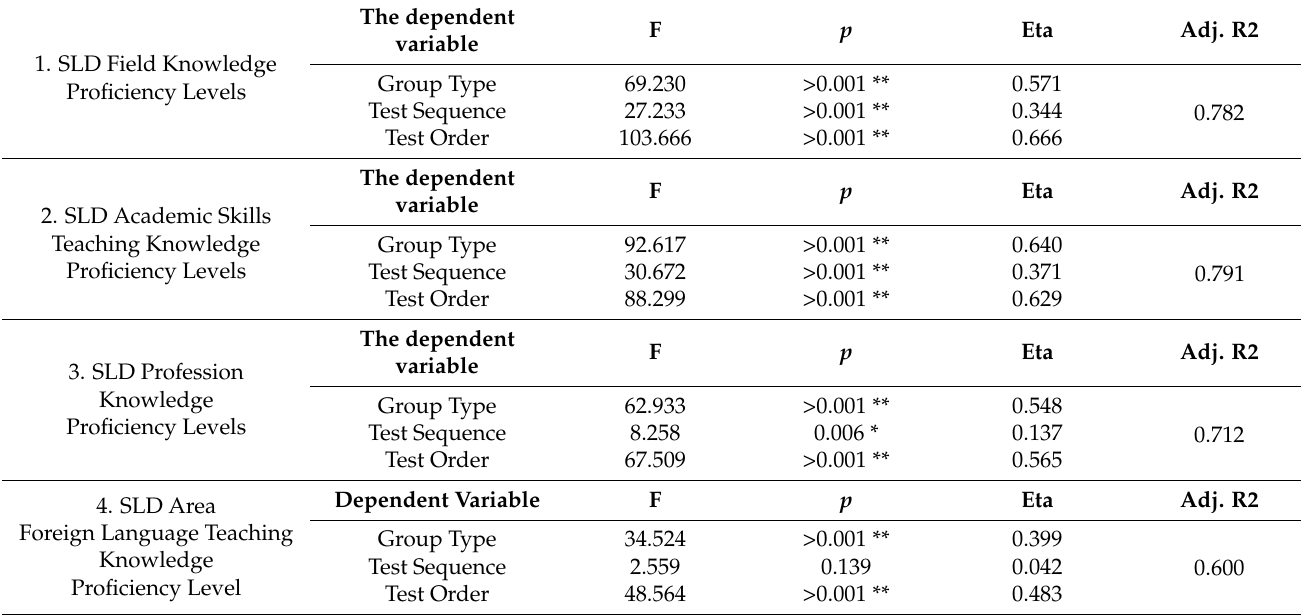
Table 5. Differentiation analysis of participants’ SLD domain proficiency levels according to group type and test